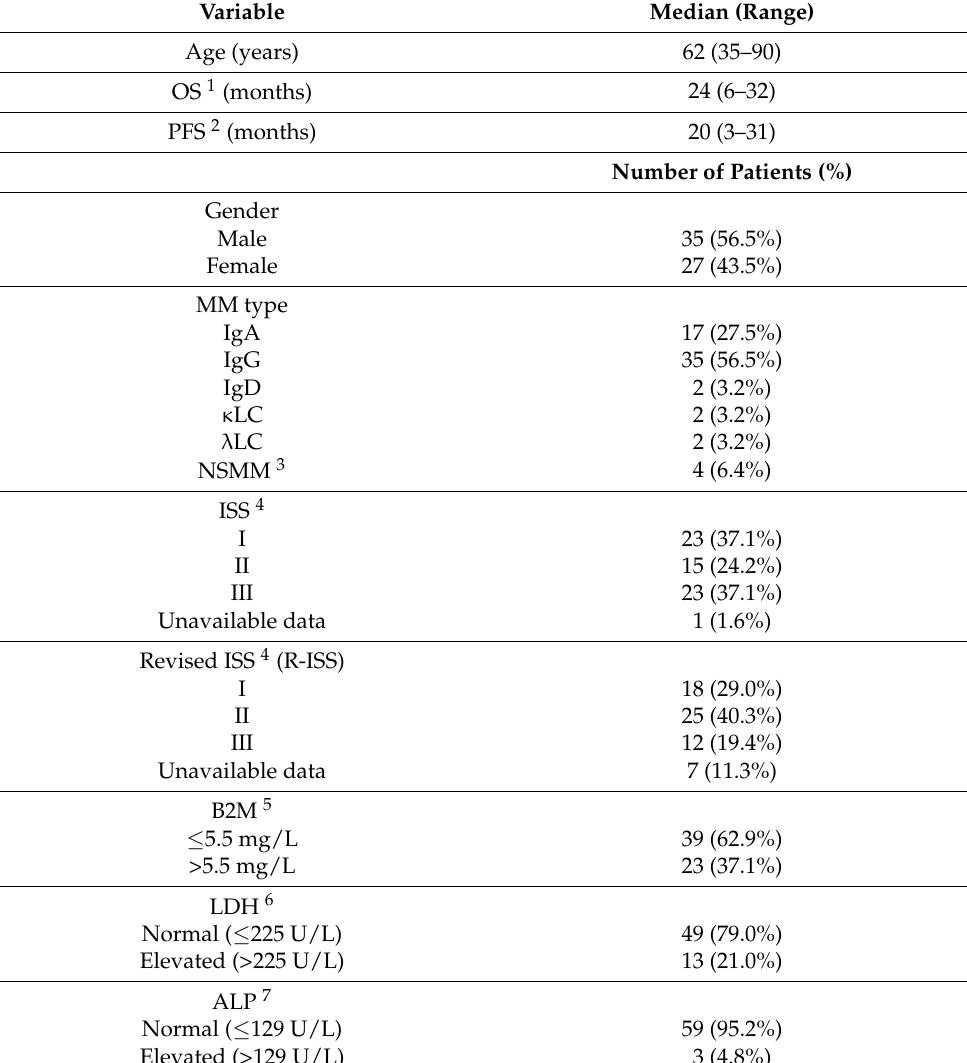
Table 1. Baseline clinical characteristics of MM